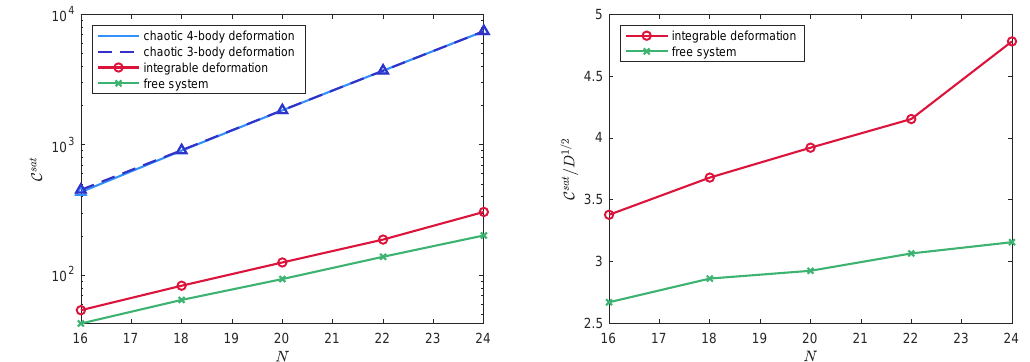
Figure 4: Plots of the saturation value of complexity (left) and the saturation value (cid:112) D (right) against N for different systems, locality degree of complexity divided by k = 4 and for the range N = 16,18,...,24. On the left, we display, in addition to the integrable and free systems, 3 realizations of each chaotic Hamiltonian using trian- gles and the spread amongst the chaotic runs can be observed to be very small. The blue lines connect their mean value at every D . On the right, we illustrate the slower (cid:112) D , which re- growth of the integrable models by dividing the complexity curve by moves the exponential dependence on N . This normalization matches the complexity convention used in [ 20,21 ] , as explained in footnote 7. For all deformations, we set ε =